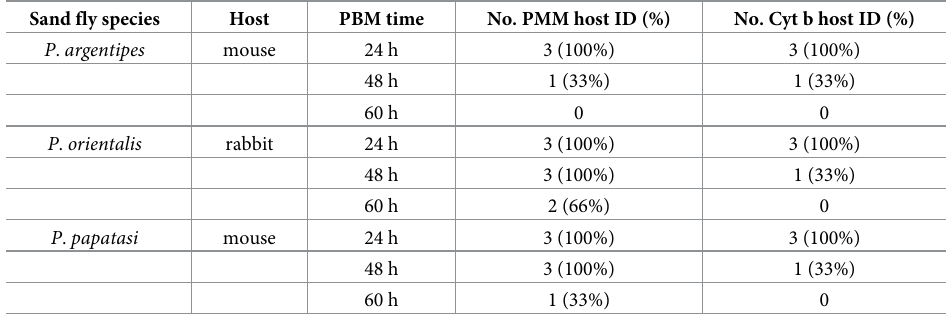
Table 2. Parallel host identification using PMM-based MALDI-TOF mass spectrometry and cyt b sequencing. Sand fly species Host